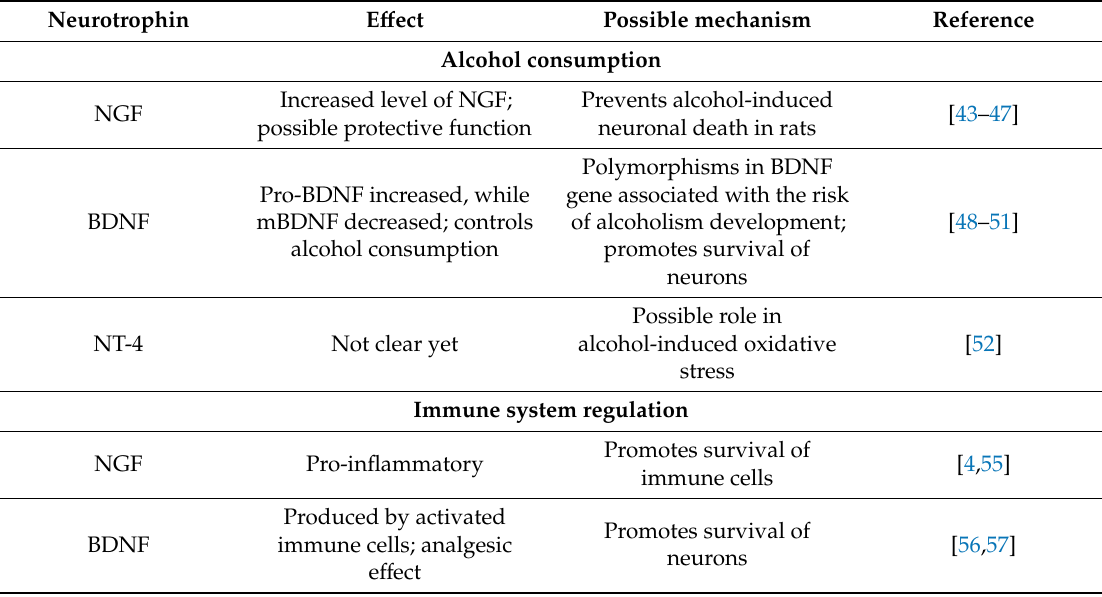
Table 1. Potential role of neurotrophins in alcohol addiction and immune system